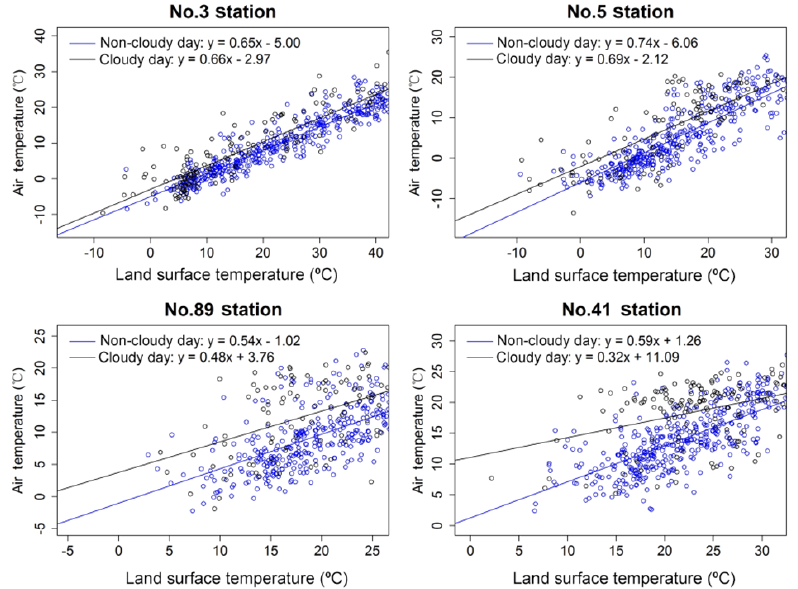
Figure 11. Comparisons of T max estimation accuracy between “cloudy day” and “non-cloudy day” conditions at four meteorological stations presenting the largest decline in RMSE.